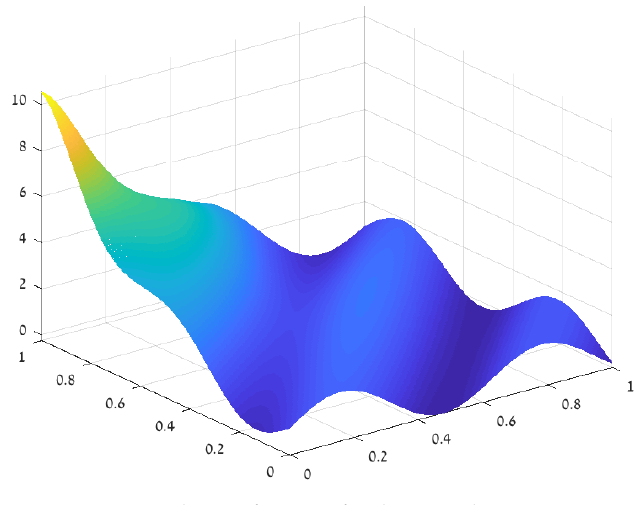
Figure 8. The test function for the smooth 2D case.